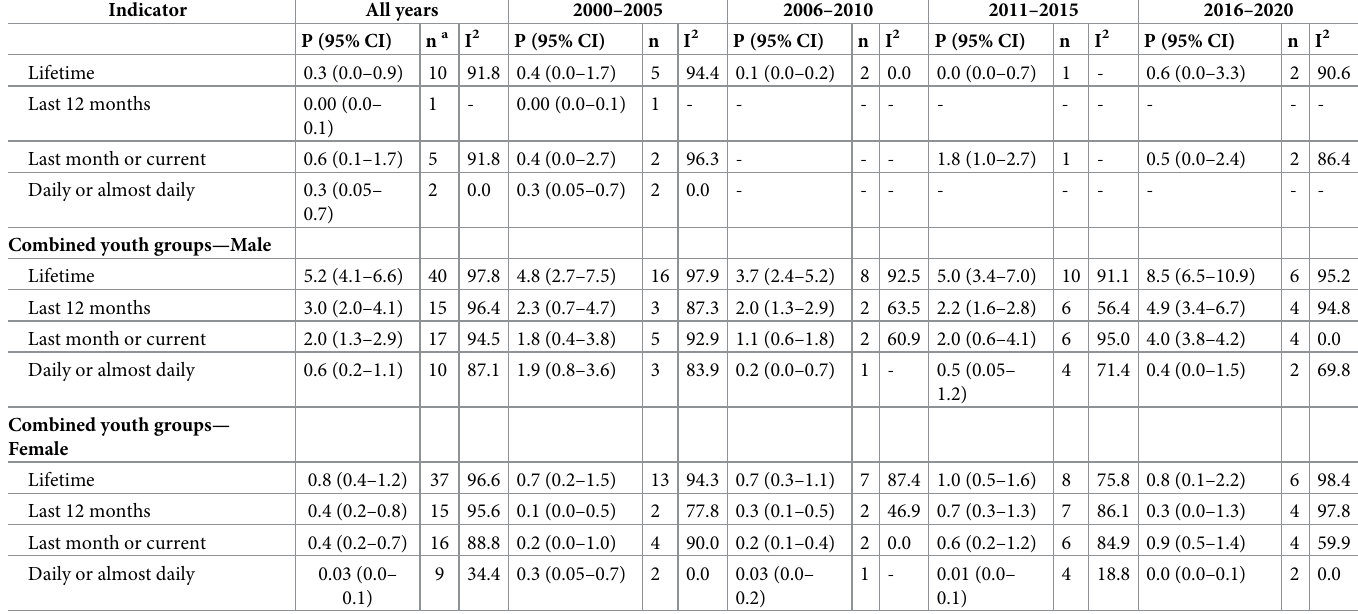
were conducted in eight different provinces. The mean ages of respondents ranged from 13.6 to 17.9 years. The pooled estimates of lifetime prevalence of cannabis use were 3.2% (95%CI: 1.7–5.3; I 2 = 97.0%; 14 studies) and 0.3% (95%CI: 0.0–0.9; I 2 = 91.8%; 10 studies) in male and female students, respectively. Only one study reported on the last 12-month prevalence among high-school students, 1.0% of male and 0.0% of female students report such use [74]. The pooled prevalence of last month or current use were 3.2% (95%CI: 1.4–5.6; 6 studies) among male students (Table 5 and S7 Fig) and 0.6% (95%CI: 0.1–1.7; I 2 = 91.8%; 5 studies) among female students (Table 5 and S8 Fig). The corresponding estimates for daily or almost daily use were 2.7% (95%CI: 1.6–3.9; I 2 = 28.7; 2 studies) and 0.3% (95%CI: 0.05–0.7; I 2 = 0.0%; 2 stud- ies) among male and female students, respectively. Cannabis use disorder was assessed in only in one study. Conducted in 2001 among male students in one province, no current use disor- der was detected among the